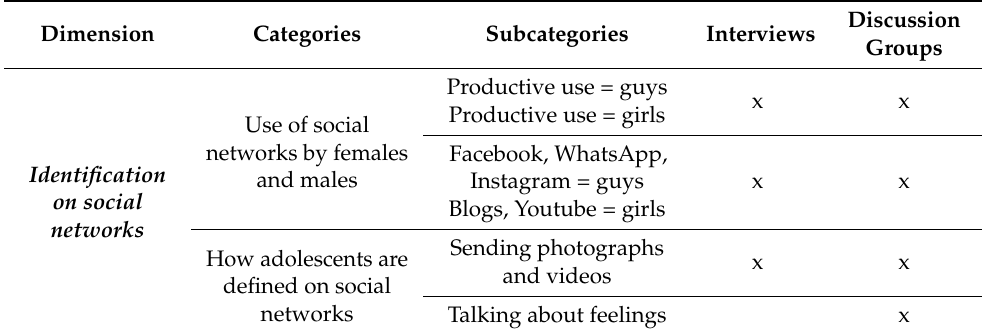
Table 2. Categories and subcategories to emerge from the study according to different